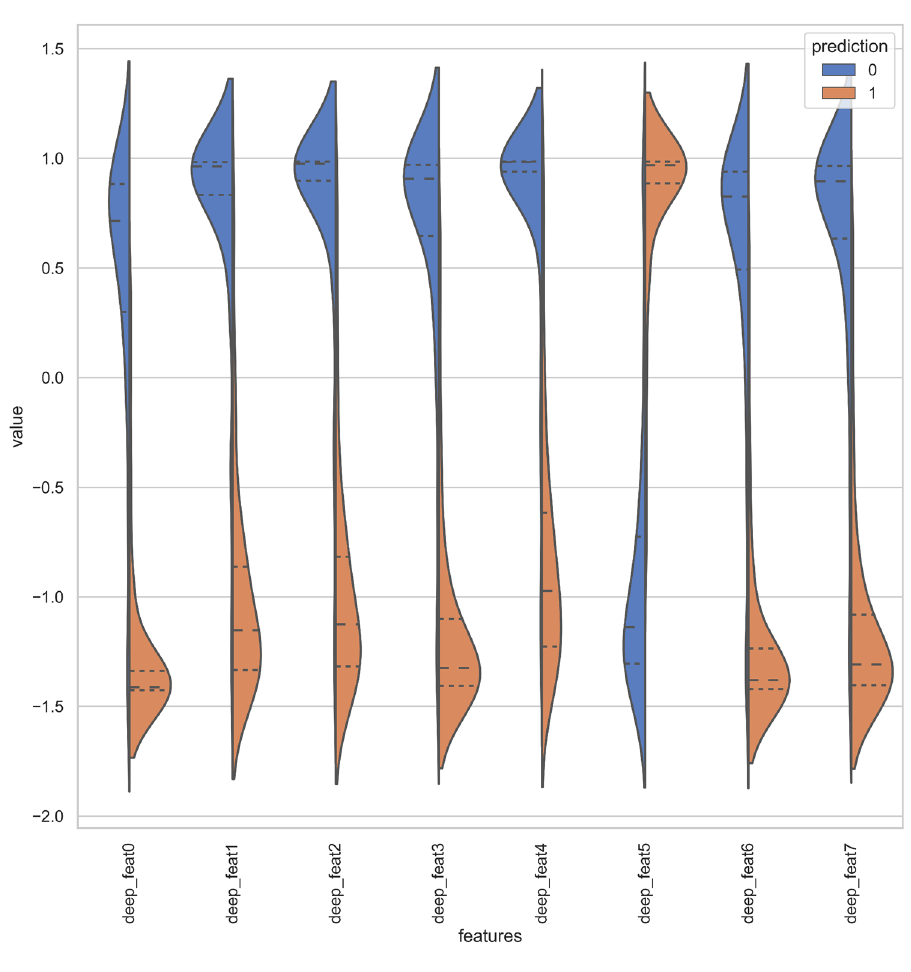
Figure 7. Violin plot of positive and negative class distributions learned by CNN representation.